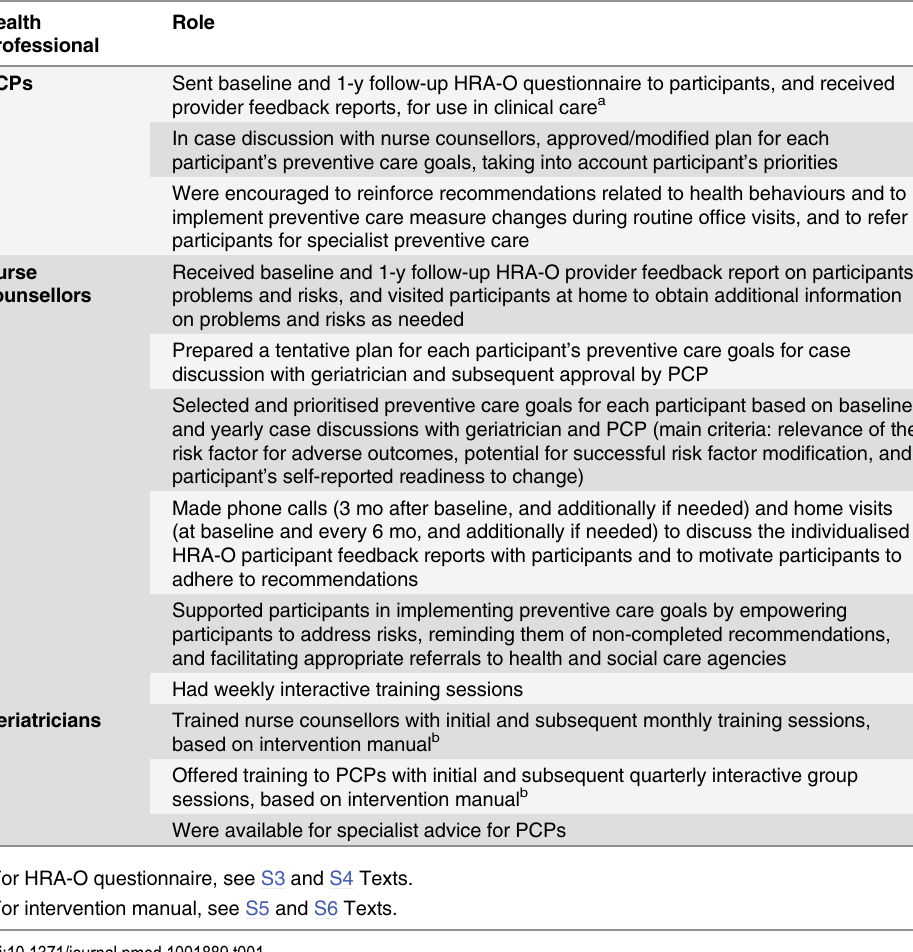
Table 1. Role of health professionals in the